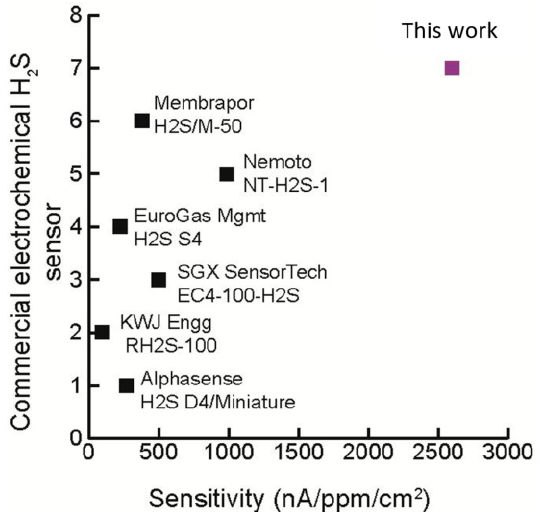
Figure 4. Comparison of area-normalized H 2 S sensitivity ranges for several commercial amperometric sensors. The sensitivity of the integrated sensor is approximately 2.5 times higher than the sensitivity of commercial sensors.